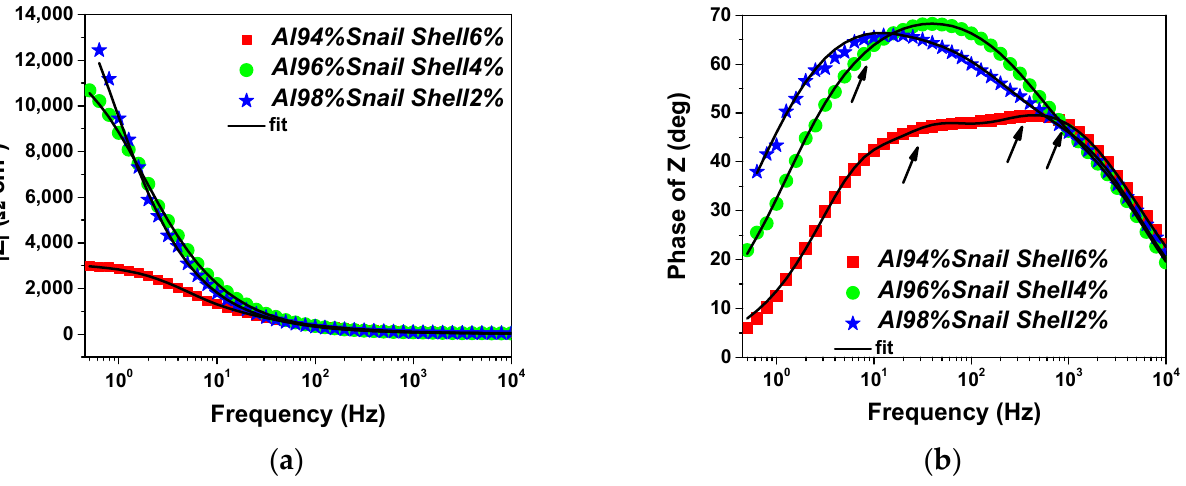
Figure 5. ( a ) Magnitude and ( b ) phase Bode plot of the investigated specimens (Scatter line—measured data, continuous line—fitted data).